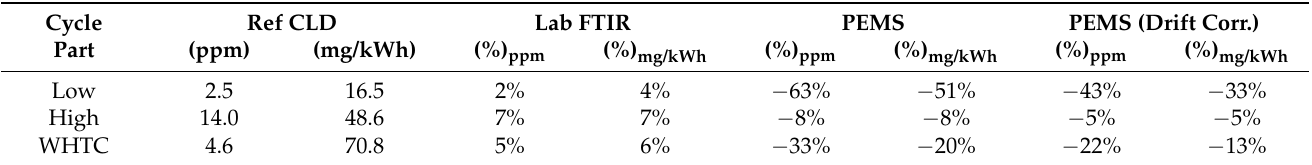
Table A1. NO x emissions of a WHTC separated at a part with low emissions, high emissions, or the complete cycle, as determined with the reference CLD. Differences of other instruments to the reference using average concentrations (ppm) or emission rates (mg/kWh). Ref CLD Lab FTIR PEMS PEMS (Drift Corr.)